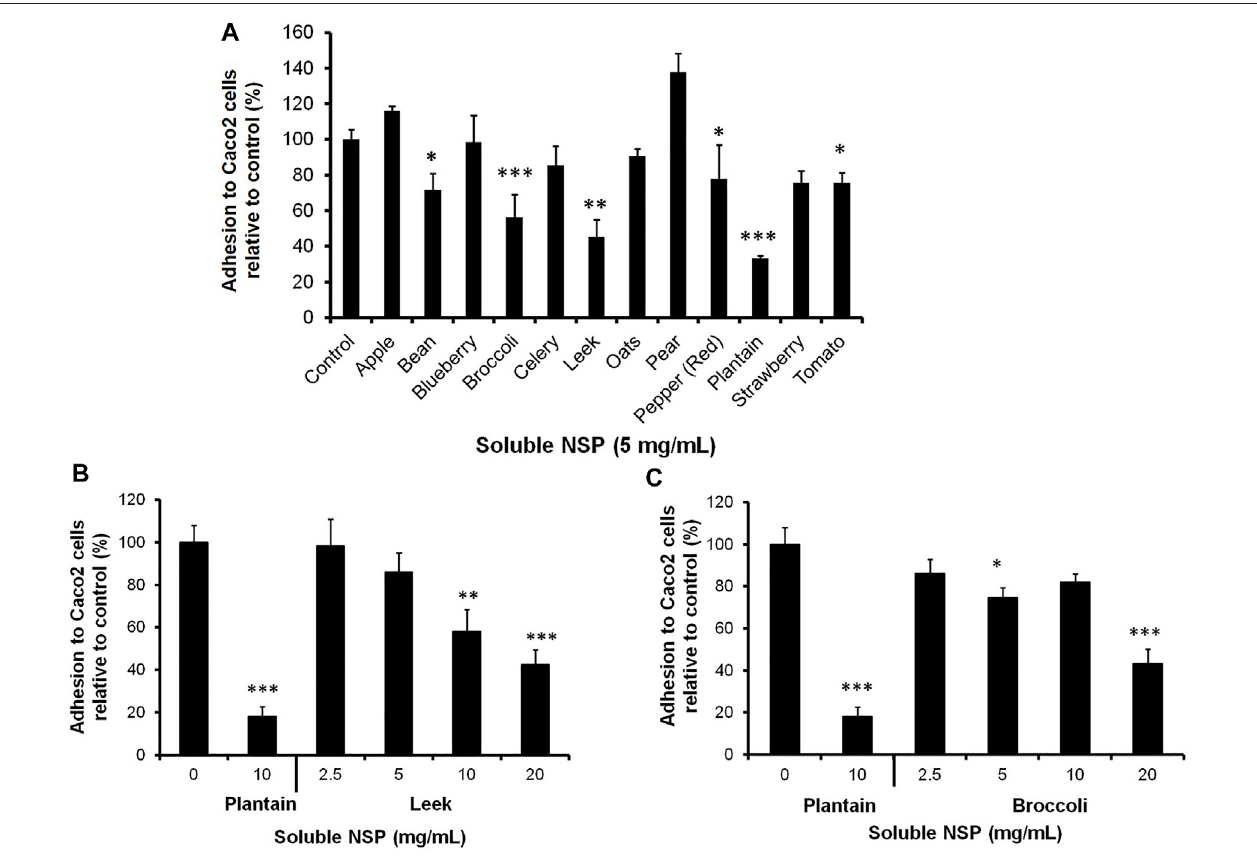
FIGURE3| Evaluationofarangeofdietaryplantsolublenon-starchpolysaccharides(NSP)fortheirabilitytopreventtheadhesionof C.dif fi cile tointestinalepithelial cells invitro . (A) Adhesionof C.dif fi cile isolate080042tocon fl uentCaco-2[Caco2]cellsmonolayersissigni fi cantlyinhibitedinthepresenceof5 mg/mlNSPfromrunner bean,broccoli,leek,bellpepper,plantainandtomato.Furtheranalysisshowed C.dif fi cile epithelialadhesiontobereducedinadosedependentmannerby, (B) leekNSP and (C) broccoli NSP, compared to blockade seen with 10 mg/ml plantain NSP. Adhesion was measured as relative to CFU/mL quanti fi ed in the absence of NSP (set as 100%). All N (cid:2) 3 experiments, n (cid:2) 3 – 4; excepting for leek NSP ( N (cid:2) 1, n (cid:2) 3); * p < 0.05, ** p < 0.01 and *** p < 0.001; Kruskal-Wallis test).